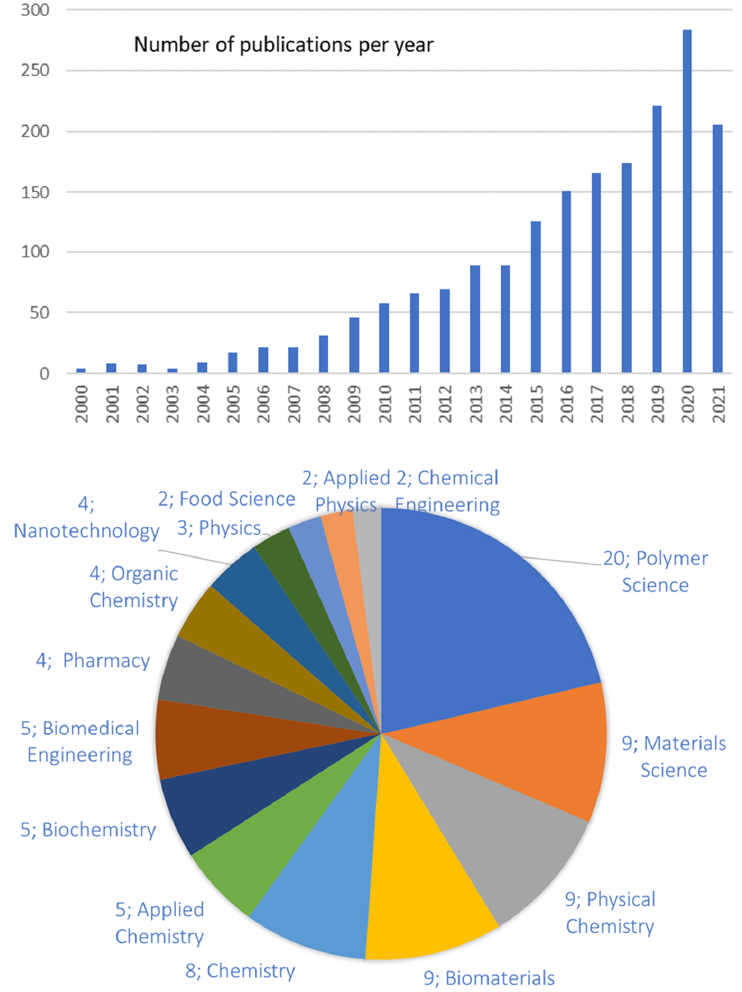
Figure 1. Top : Number of scientific publications in the last 20 years on rheology of hydrogels. Bottom : disciplinary areas related to the publications. Source: ISI Web of Science, November 2021, search keywords: “rheology” AND